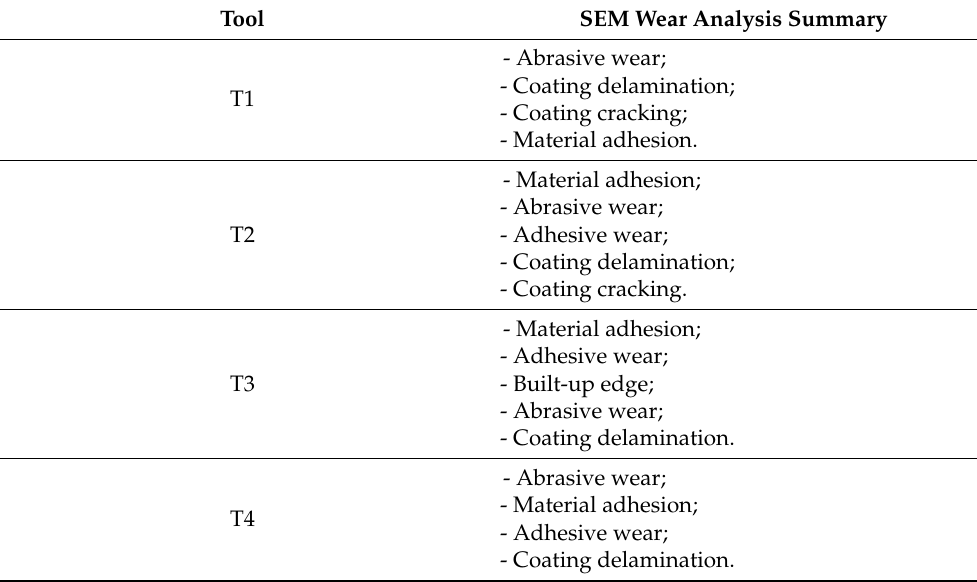
Table 16. Summary of the SEM wear analysis for each of the tested tools, mentioning the main wear type and mechanism